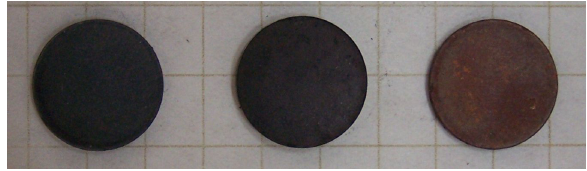
Figure 9: Photos of the samples for electrical conductivity measure-